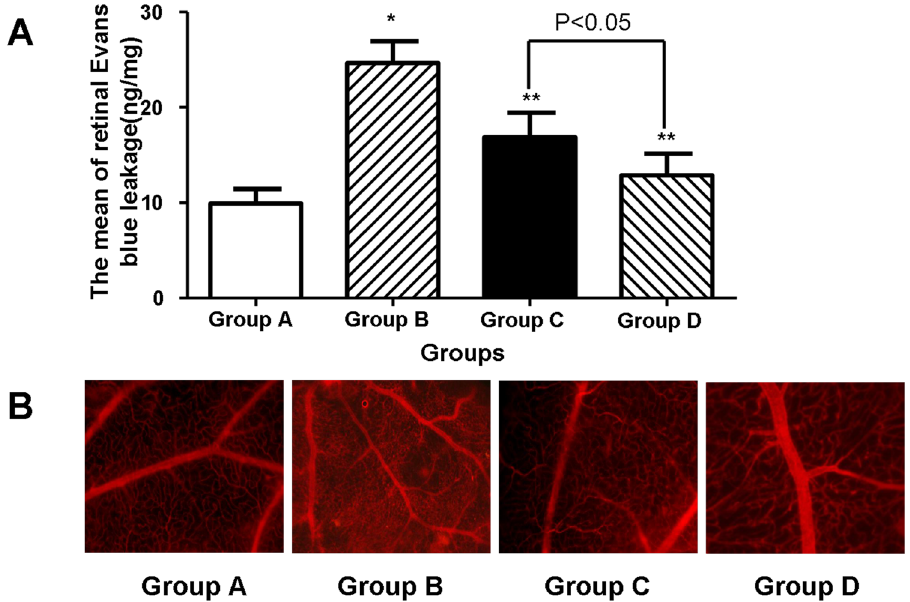
Figure 5. The protective effect of NSC on diabetic-induced BRB permeability. ( A ) Mean retinal EB dye leakage in the retinal blood vessels. There were significant differences in the retinal EB dye leakage between rats with DR (Group B: n = 6) and Group A (n = 6). In contrast, the leakage decreased in Groups C and D. Retinal EB dye leakage in Group D was lower than that in Group C. * P < 0.05 vs. Group A; ** p < 0.05 vs. Group B. ( B ) Representative images showing EB fluorescence. In the retinas of Group A, EB fluorescence was limited to the blood vessels, whereas in Group B, the dye leaked out of the vessels to the retinal tissue (arrows). Treatment in Groups C and D prevented the leakage of EB. Magnification